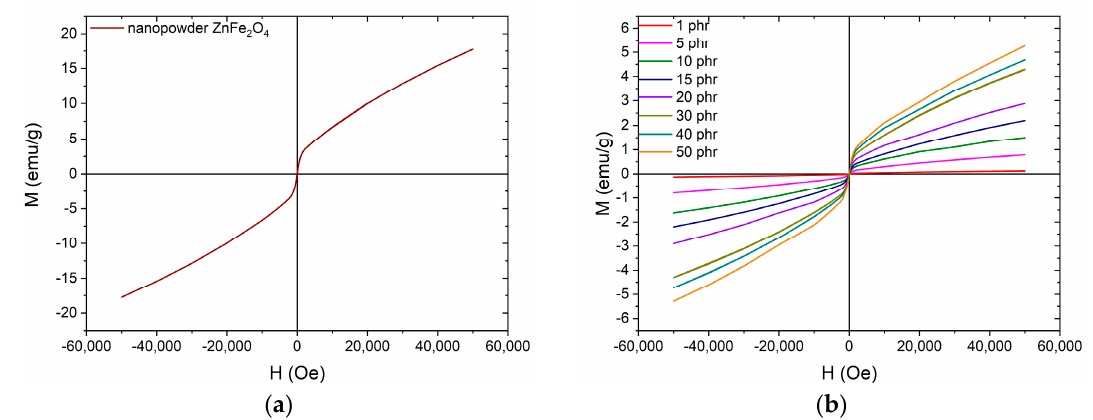
Figure 8. Magnetic hysteresis loops for the: ( a ) ZnFe 2 O 4 nanopowder and ( b ) nanocomposites with varying ZnFe 2 O 4 filler content.